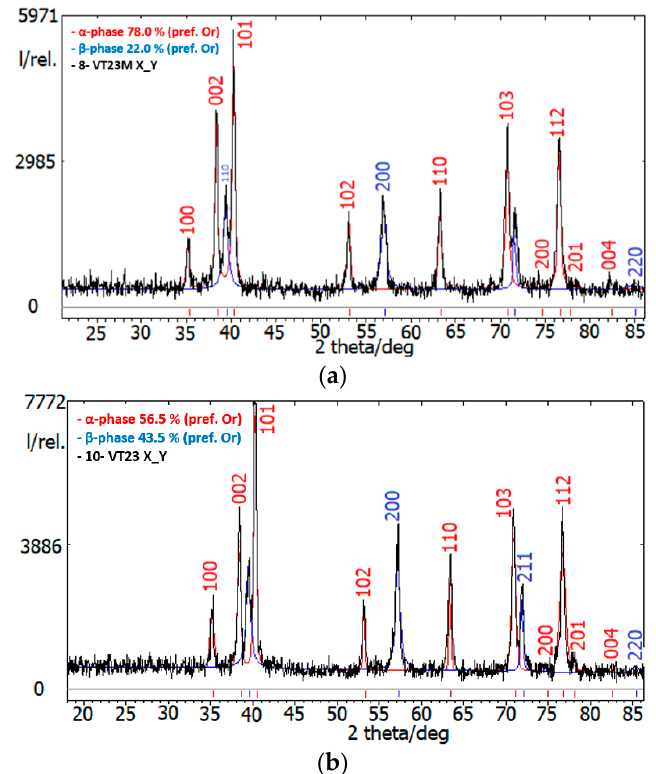
Figure 2. Results of diffractometric study on the evaluation of percentage of α and β phases in the studied titanium alloys: ( a ) VT23M alloy ( β‐ phase occupied 22% by weight, α‐ phase was 78% by weight); ( b ) VT23 alloy ( β‐ phase occupied 43% by weight, α‐ phase was 57% by weight). Table 4. Parameters of deformation and fracture of specimens from alloy VT23.